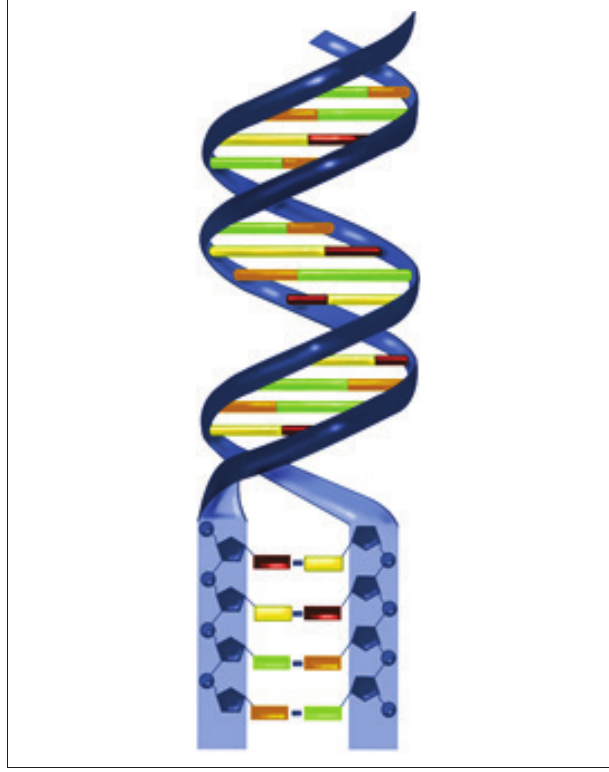
FIGURE 1: Everyday reasoning, the mathematical and